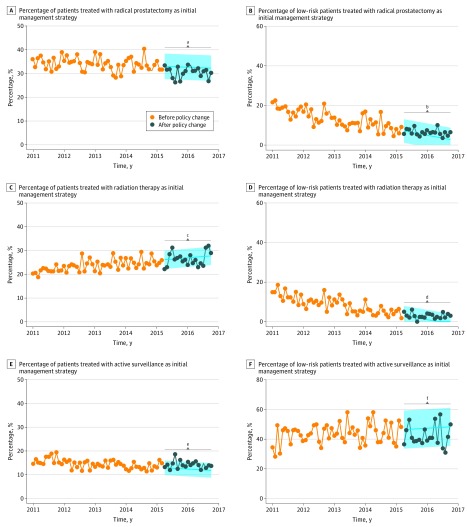
Initial Management of Localized Prostate Cancer Among 33 128 Patients and Proportion of Low-risk Patients in Each Management StrategyThe shaded areas represent the predicted 95% CIs, and the P values are based on a step function with a 0-order response.aP = .004.bP = .56.cP = .53.dP = .67.eP = .73.fP = .42.